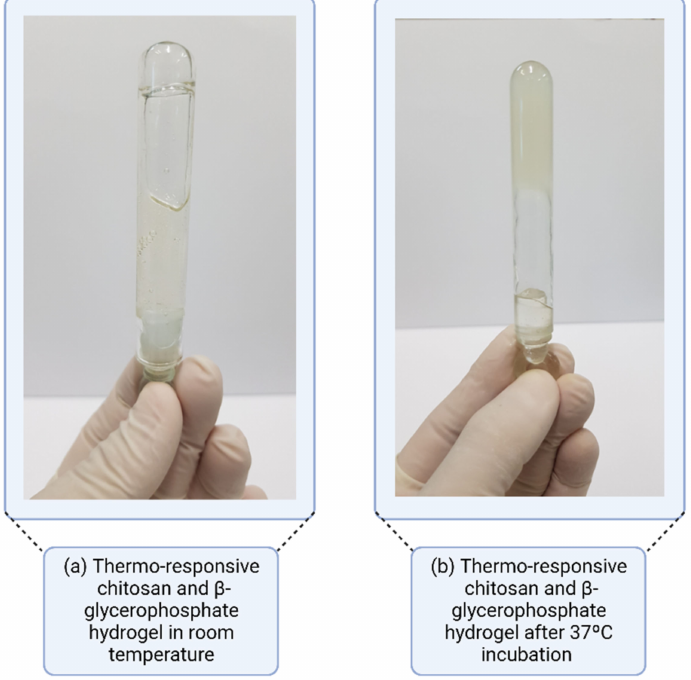
Figure 10. Thermo-responsive gel system with lowest critical